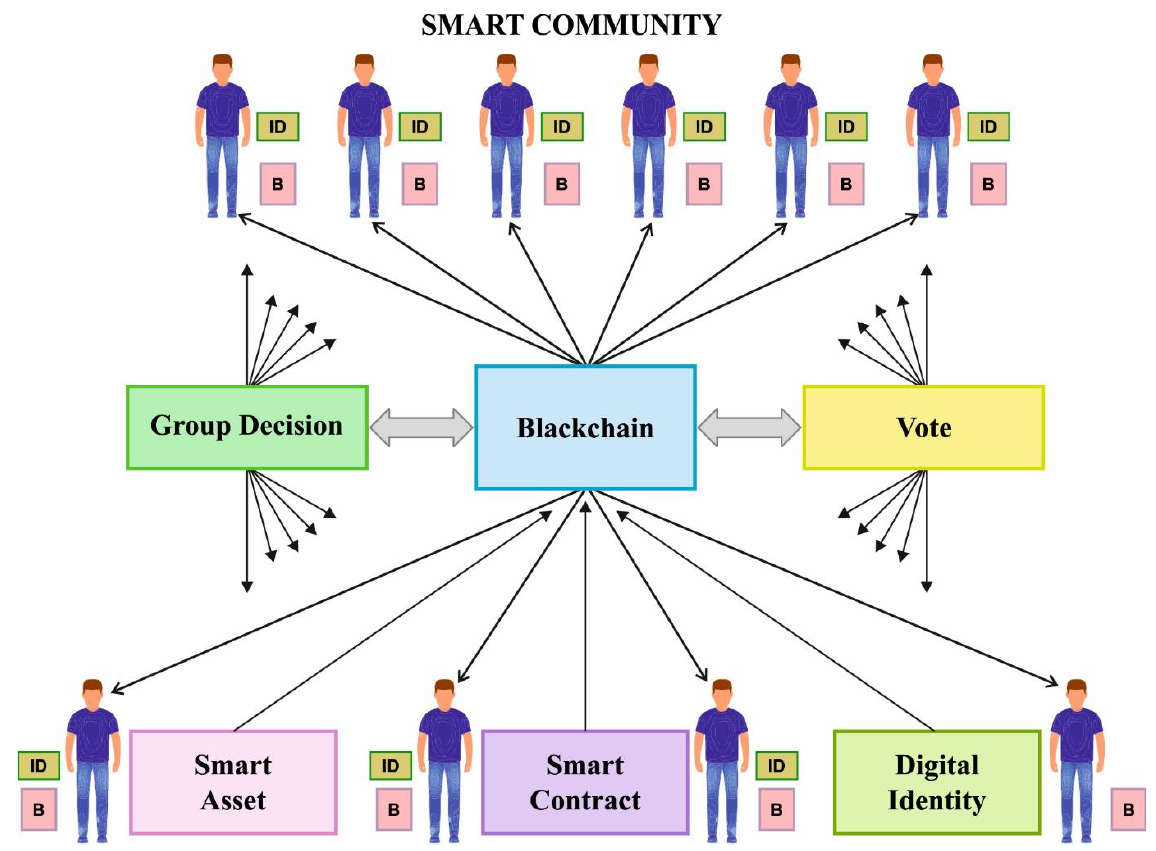
Figure 1. Blockchain in IoT with smart cities environment.